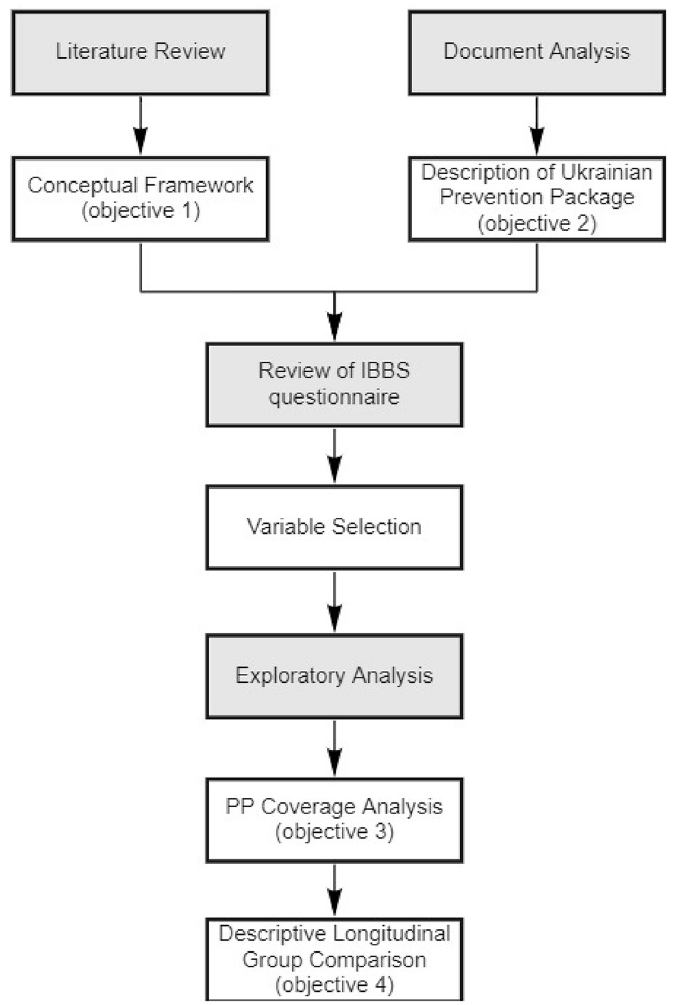
Fig 1. Flowchart of methodological